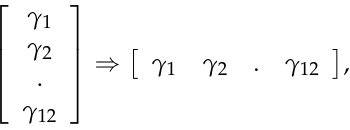
Figure 5. Flow chart of error correction algorithm based on game rules. The feature matrices with layer numbers (cid:1876) (cid:2869) , (cid:1876) (cid:2870) , and (cid:1876) (cid:2871) are extracted from the feature array of real-time recognition. First, we need to calculate the similarity between the x 1 layer characteristic matrix and the (cid:1876) (cid:2869) layer matrix of 01 and 02 and record the gesture numbers with greater similarity. If the correct identification number is 01 at this time, we choose the feature matrix layer with the biggest difference between 01 gesture and 02 gesture, so this game is equivalent to comparing the strengths of 01 with the weaknesses of 02, and the result is very obvious. Using the same method to calculate the similarity between the (cid:1876) (cid:2870) layer feature matrix and the (cid:1876) (cid:2870) layer matrix of 01 and 03, and the similarity between the (cid:1876) (cid:2871) layer matrix and the (cid:1876) (cid:2871) layer matrix of 02 and 03. Finally,